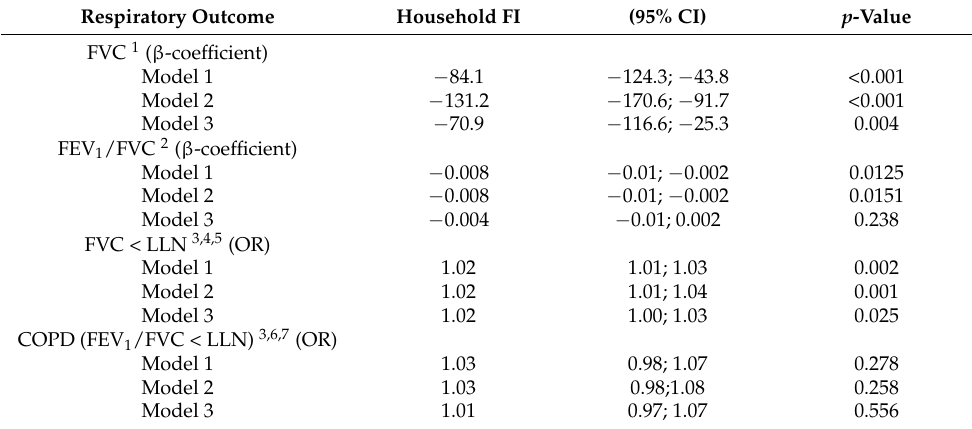
Table 3. Association between household food insecurity (FI), lung function, COPD and spirometric restriction in adults participating in